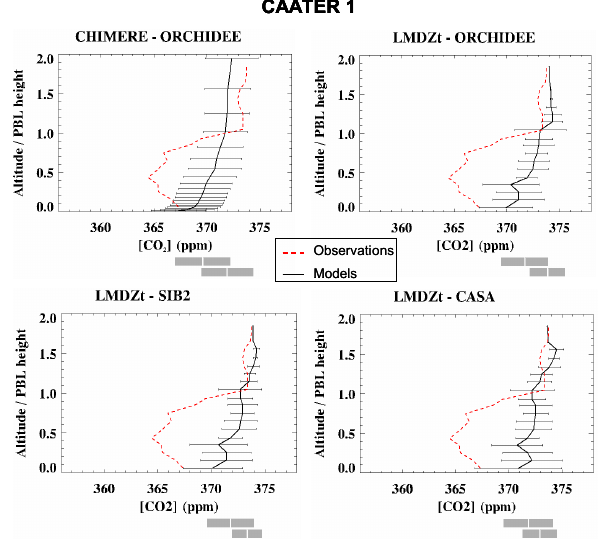
Fig. 1. Comparison of the mean modeled and observed profiles for CAATER 1. Horizontal bars represent the ± 1- σ standard deviation of the mean, computed every 1/10th of the altitude/ABL height ra- tio. Below the x-axis, the global mean and the ± 1- σ variability in the ABL (upper bar) and FT (lower bar) are shown according to the CO 2 concentration scale given by the x-axis.